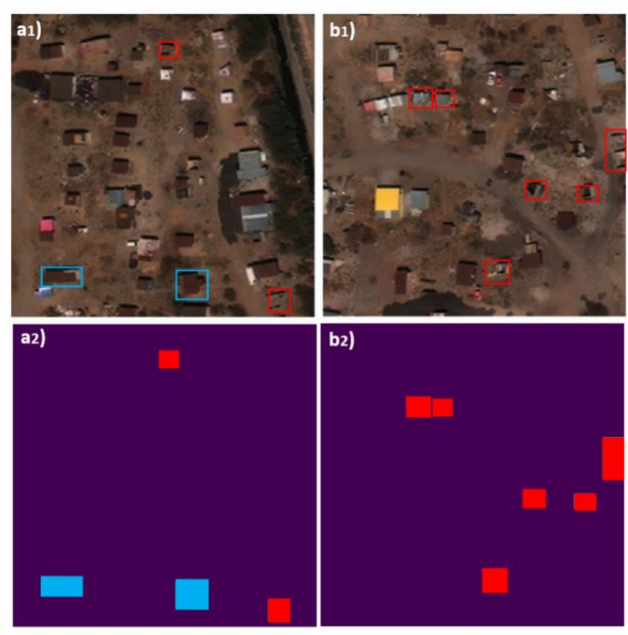
Figure 4. Two examples of input pairs (top row image and bottom row ground truth labels) to the network: ( a 1 ) A patch includes two labels for each of the classes; ( a 2 ) Ground truth mask for a 1 patch; ( b 1 ) A patch includes only six labels of the demolished building class; ( b 2 ) Ground truth mask for b 1